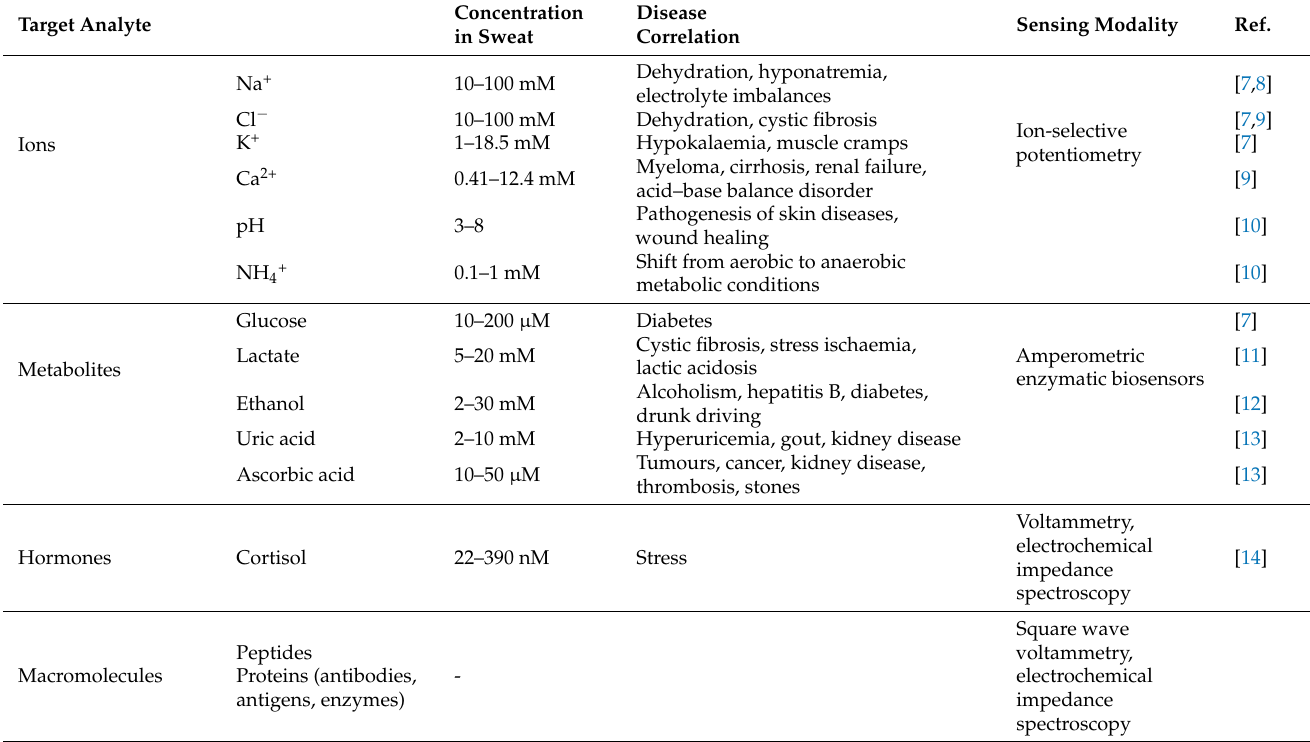
Table 1. Key analytes in sweat and the related detection methods. Adapted with permission from Refs. [5], Copyright 2021, and [6], Copyright